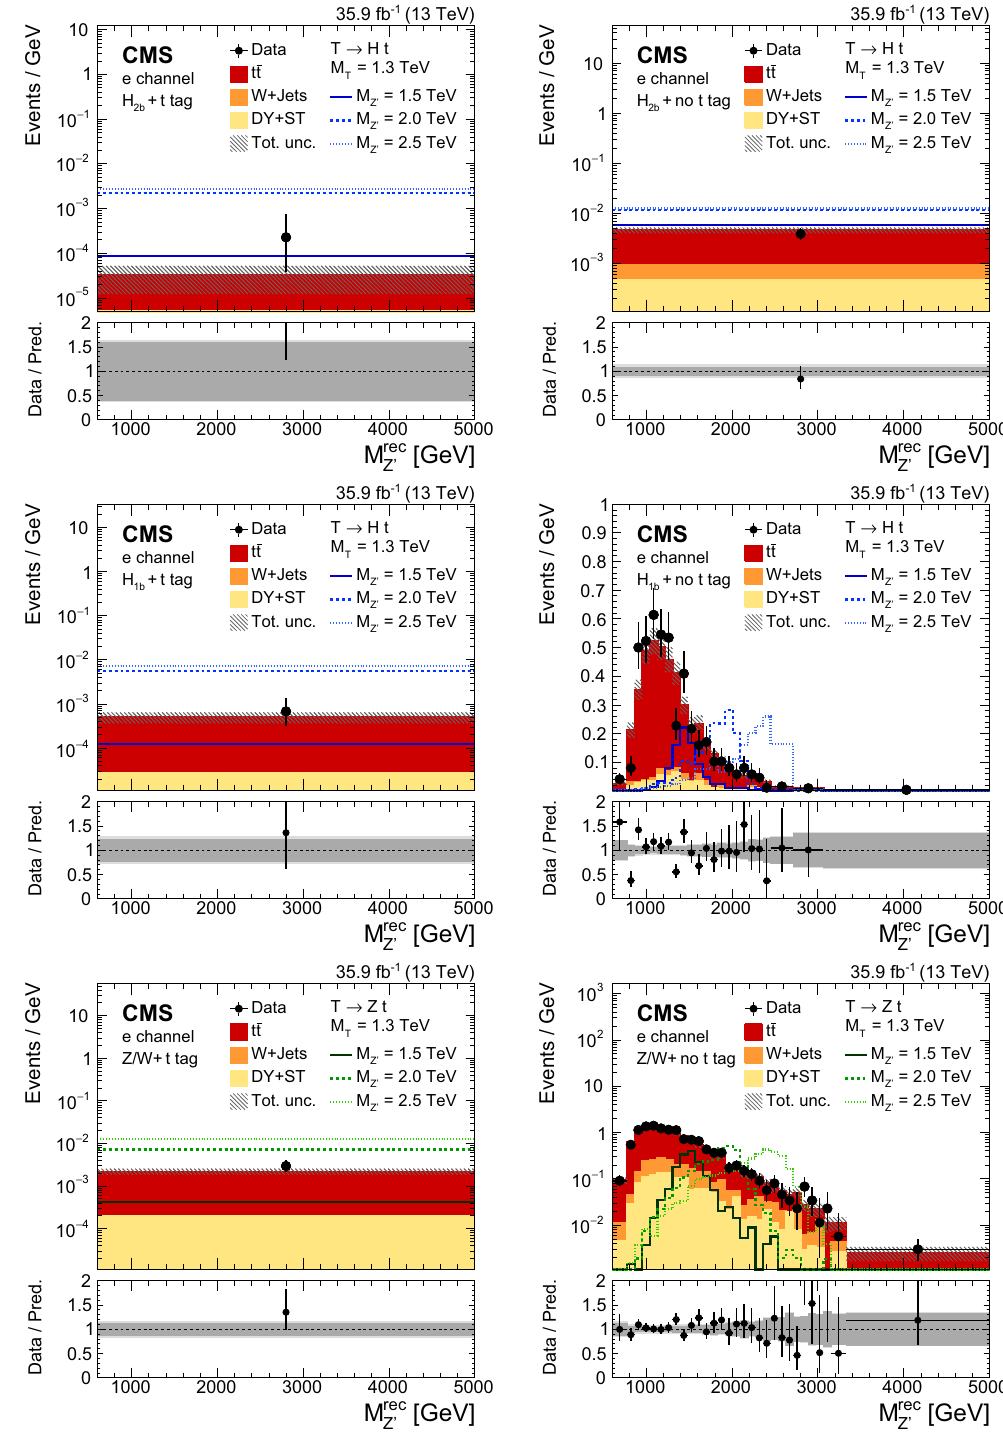
Fig. 6 Distribution of the reconstructed Z (cid:3) resonance mass after the full selection in the e+jets channel for the data, the expected SM back- ground, and for the signal with different Z (cid:3) masses for a fixed T mass of 1.3TeV. In the left (right) column the results in the top tag (no top tag) category are shown. Different rows display the distributions of events accepted by different taggers as well as the signal for the respective T decays: H 2b tagger and T → Ht decay (upper), H 1b tagger and T → Ht